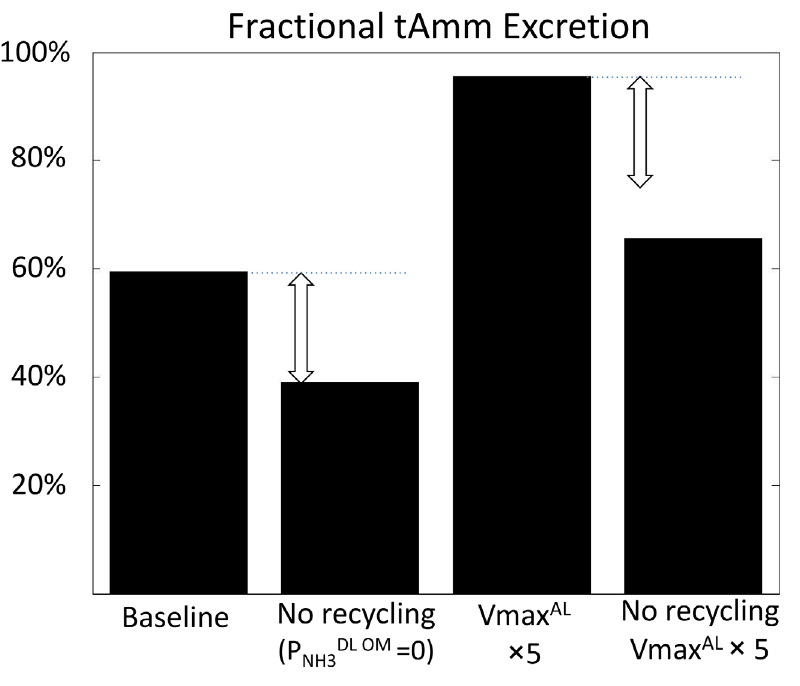
Fig 7. Inhibition of NH 3 secretion in the DL OM (permeability P DL OM NH in the loops of Henle, which limits urinary ammonia excretion. The effect is more potent when ammonia reabsorption in the MTAL is increased (maximum rate of active transport Vmax AL